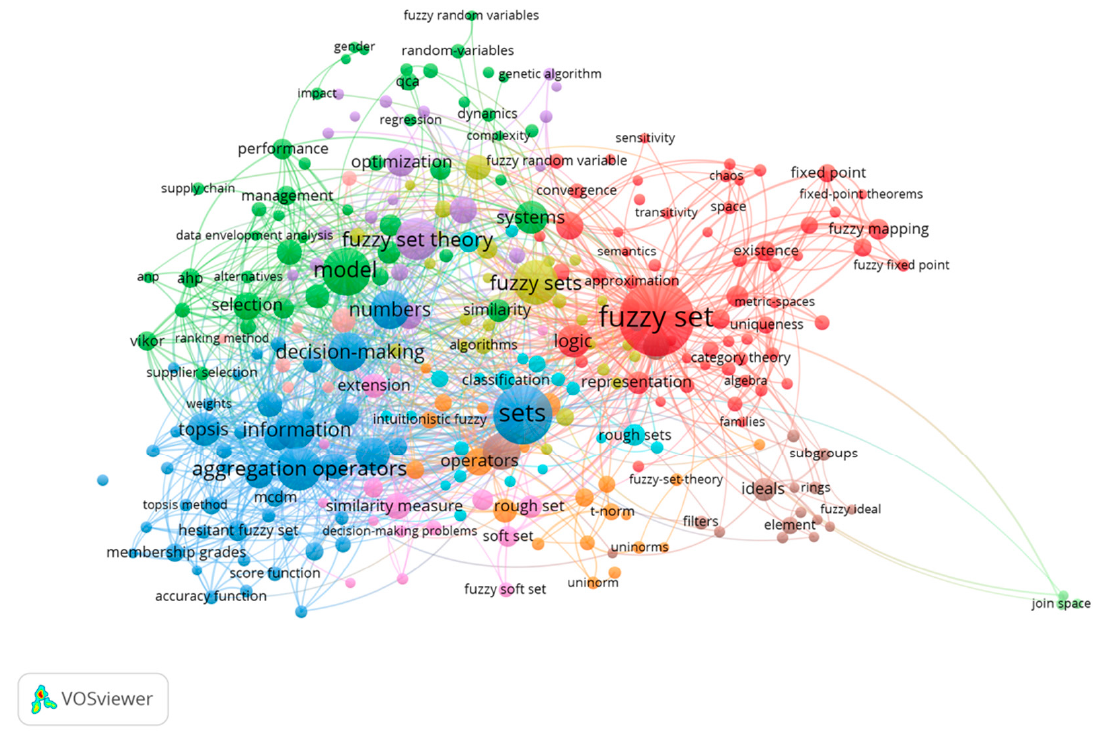
Figure 5. Co-occurrences for all keywords. Network visualization.